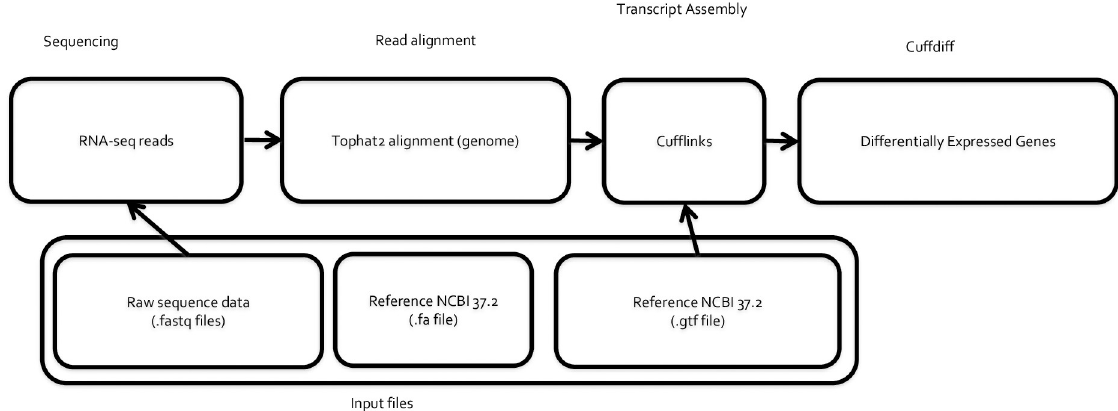
Fig 7. Data analysis workflow for transcriptomic analysis of C57BL/6 mammary glands at lactation day 11.